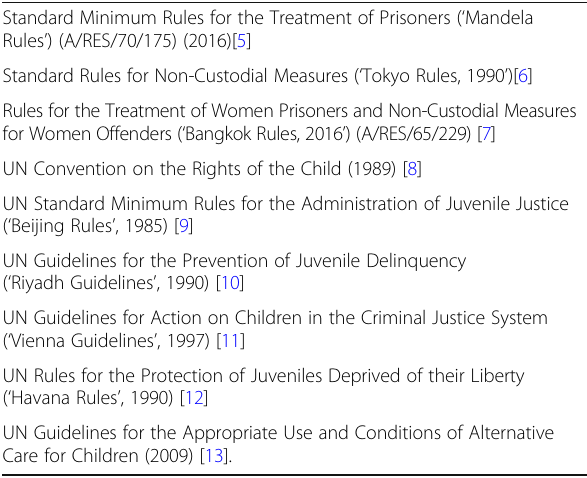
Table 1 Treatment and special protection of the rights of incarcerated young people in